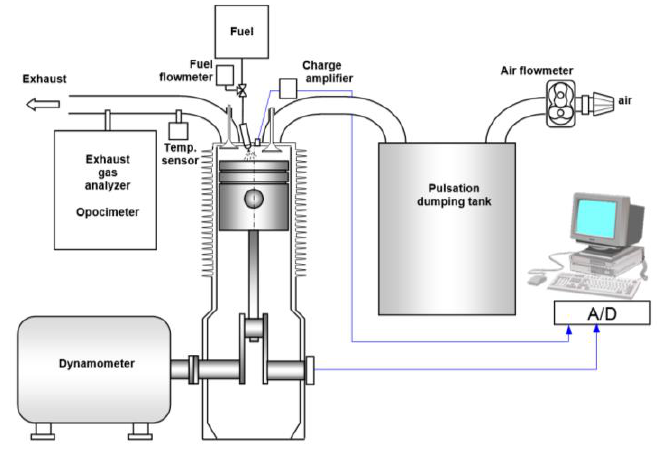
Figure 1. Diagram of the test stand. Table 2. Parameters of the Bosch BEA 350 analyzer.